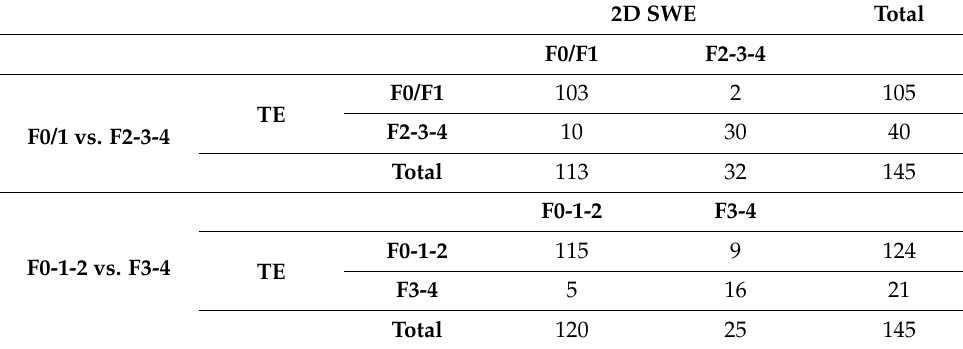
Table 2. Distribution of fibrosis stages in significant fibrosis (F0/1 vs. F2-3-4), advanced